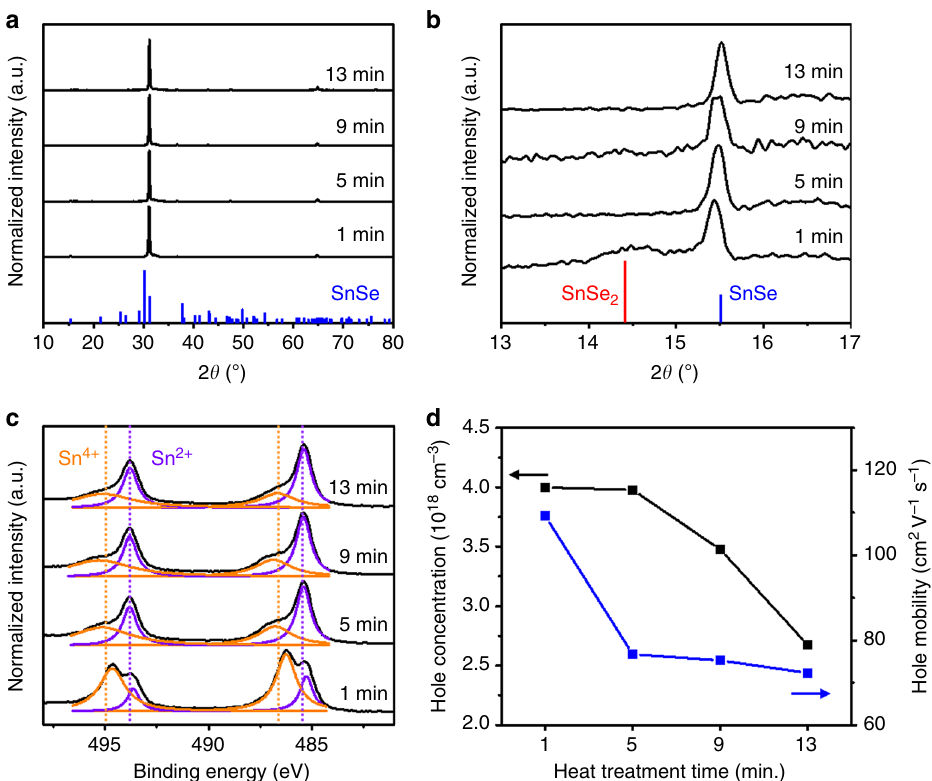
Fig. 5 Compositional engineering of SnSe thin fi lms for hole doping. a – c Structural and compositional characterization of SnSe thin fi lms annealed at 400 °C for 1, 5, 9, and 13 min by a , b XRD and c XPS analyses. Vertical lines in a and b indicate the orthorhombic SnSe (blue, JCPDS 32 – 1382) and the hexagonal SnSe 2 phase (red, JCPDS 89 – 2939), respectively. Regardless of annealing time, all thin fi lms showed XRD patterns that corresponded to the SnSe phase. Particularly, the enlarged XRD patterns in b for 2 θ ranging from 13° to 17° show the residual SnSe 2 phase in thin fi lms annealed for 1 min at 400°C. XPS spectra of thin fi lms in the region for 3d 5/2 and 3d 3/2 of Sn show distinctive peaks at 485.4 and 493.8 eV (purple dotted lines), which are identi fi ed as the Sn(2 + ) oxidation state. Additional peaks at 486.3 and 494.7 eV (orange dotted lines) detected in the 1 min-treated sample can be indexed to the Sn(4 + ) oxidation state. d Graph shows hole mobilities and hole concentrations of SnSe thin fi lms annealed at 400 °C for 1, 5, 9, and 13 min obtained by Hall effect measurement at room